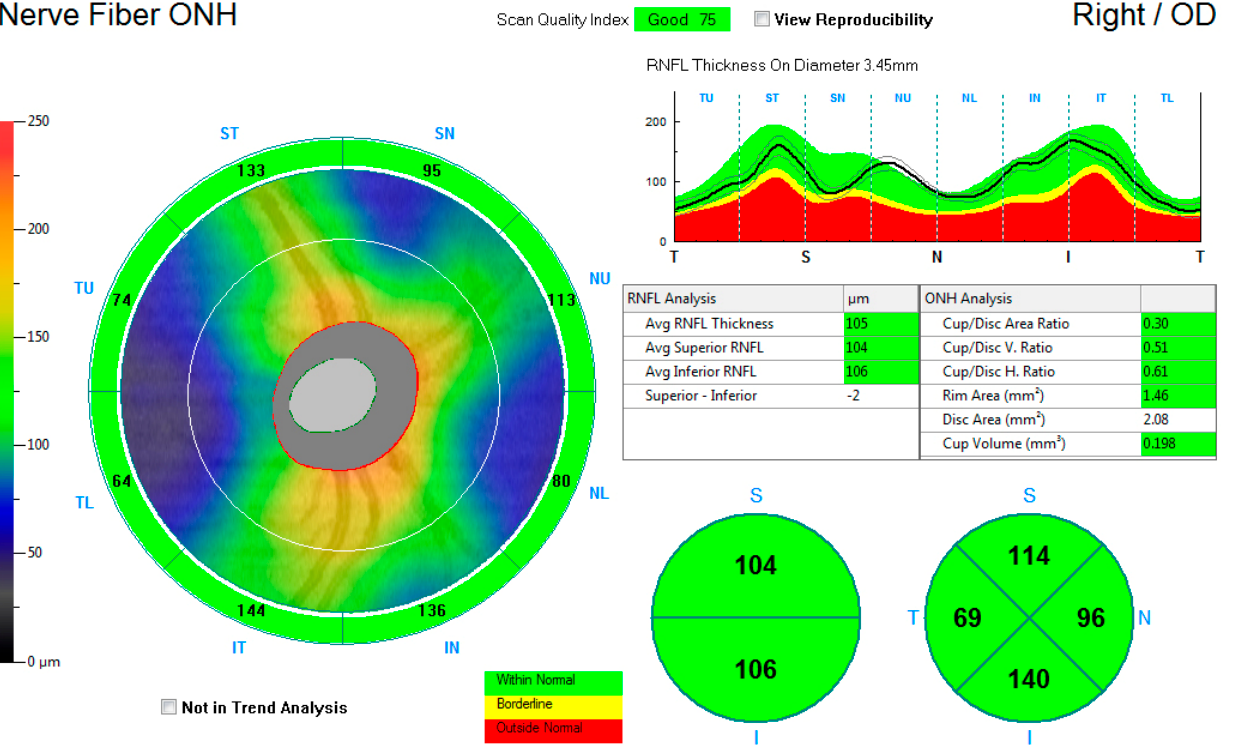
Figure 2. An illustration of the retinal nerve fibre layer thickness map around the optic nerve head.